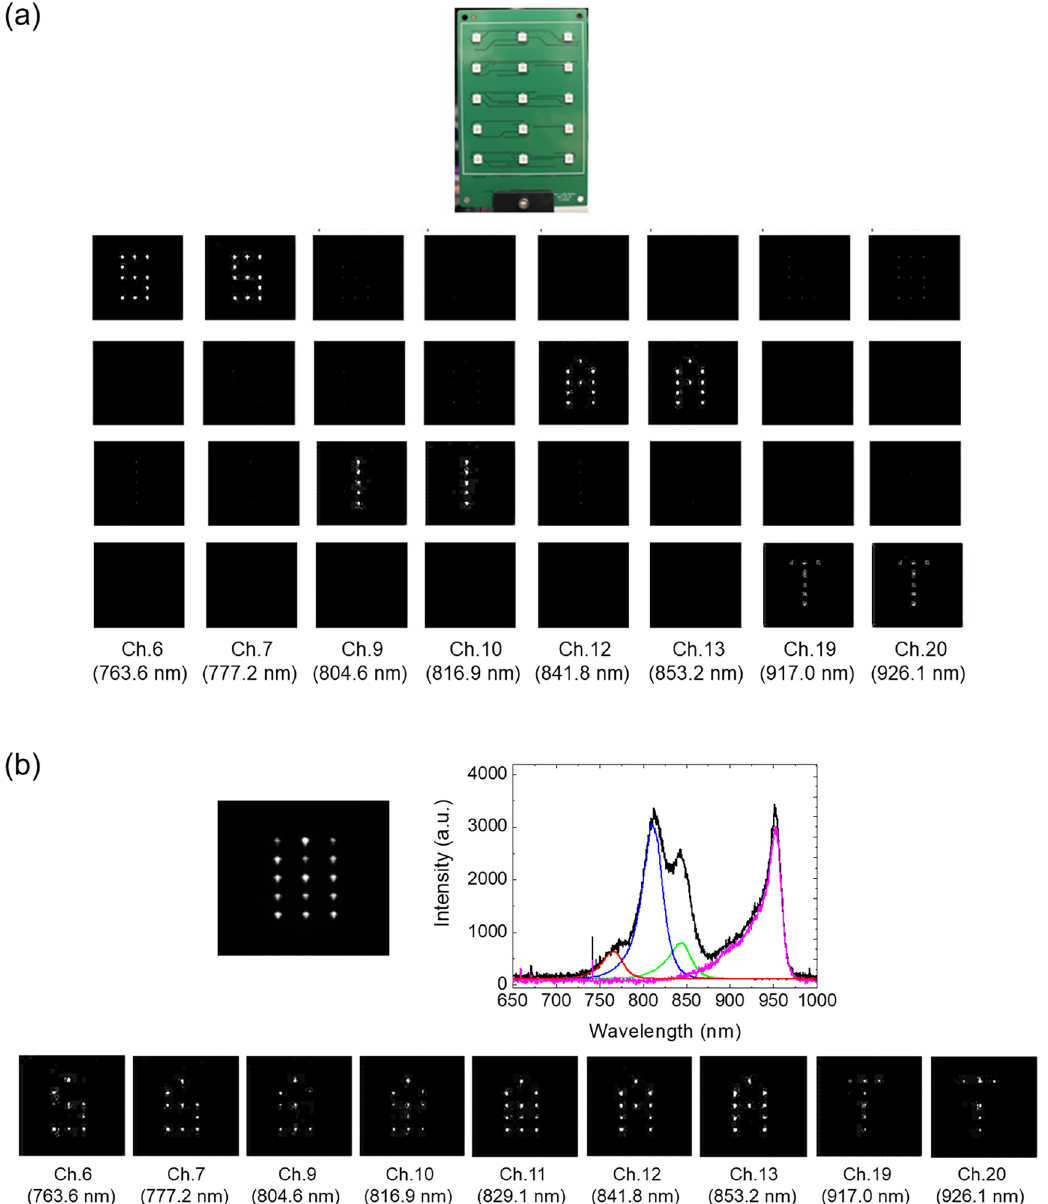
Figure 4: Hyperspectral imaging of the meta-spectral imager. (a) (Top) Photograph of the test panel for spectral imaging. (Bottom) Spectral images measured when only one letter is switched on. Letter is the brightest at the peak wavelength of LED emission. (b) (Top-left) Image of combined letters. (Top-right) Reference spectra of the LED emissions. (Bottom) Spectral images divided into 20